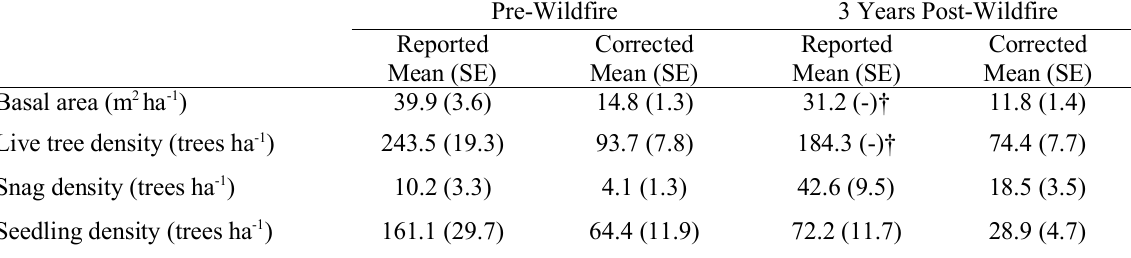
Table 1: Stand metrics as originally reported in Stephens et al. 2008 (“Reported”) and re-calculated using raw data (“Corrected”) † denotes that the values were reported only as a percent reduction from pre-fire measures, and therefore, no standard errors were given. Three years post-fire metrics are given to account for delayed